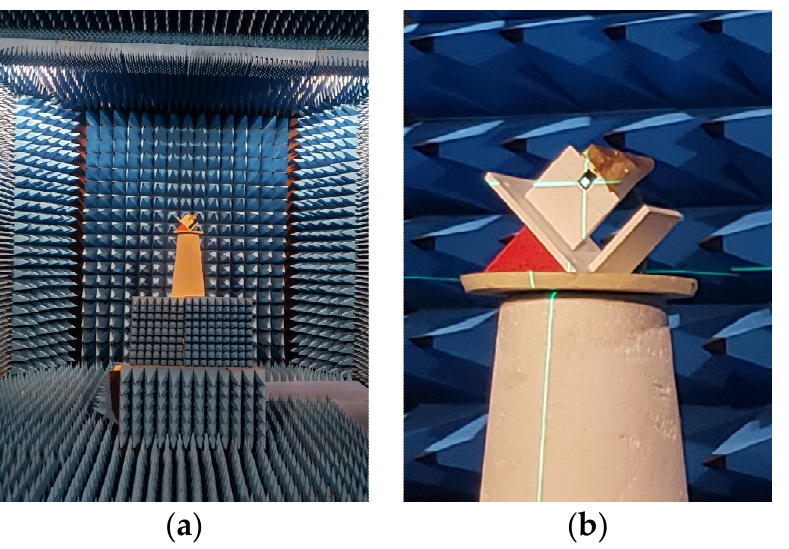
Figure 8. ( a ) An antenna under measurement in the anechoic chamber. ( b ) A close-up of the positioner.